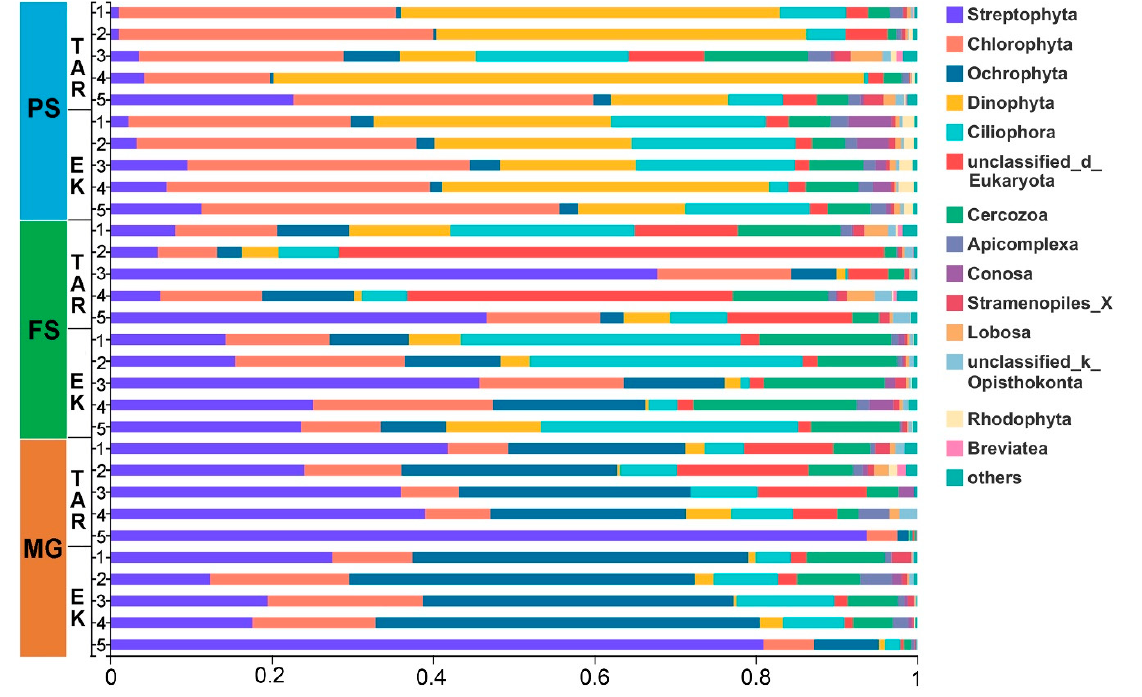
Figure 5. Relative abundances of eukaryotic communities at phylum level detected by two primer sets in samples extracted using the PS, FS, and MG kit.